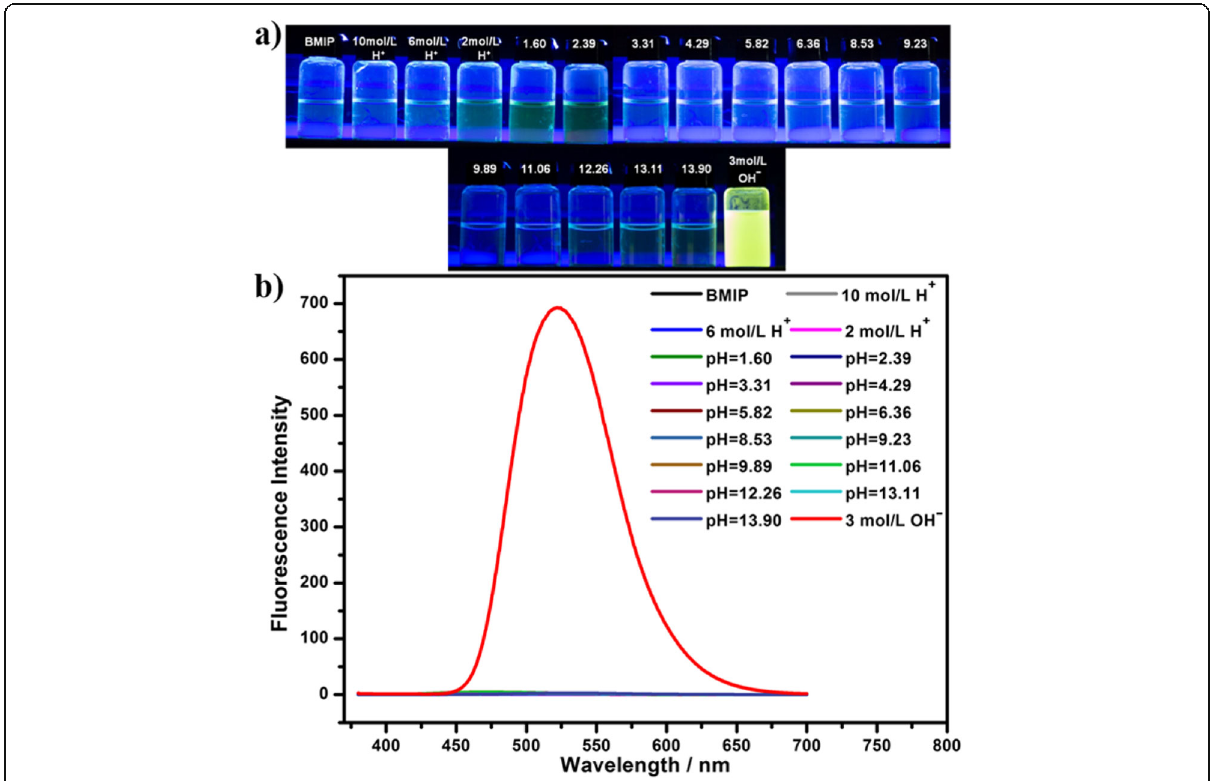
Fig. 3 a Photo comparison (under UV light) (365 nm) and b the PL spectra of aqueous solutions (1 mmol/L) of BMIP with different pH (neutral water, 10 mol/L H + , 6 mol/L H + , 2 mol/L H + , 1.60, 2.39, 3.31, 4.29, 5.82, 6.36, 8.53, 9.23, 9.89, 11.06, 12.26, 13.11, 13.90, 3 mol/L OH ˉ ,